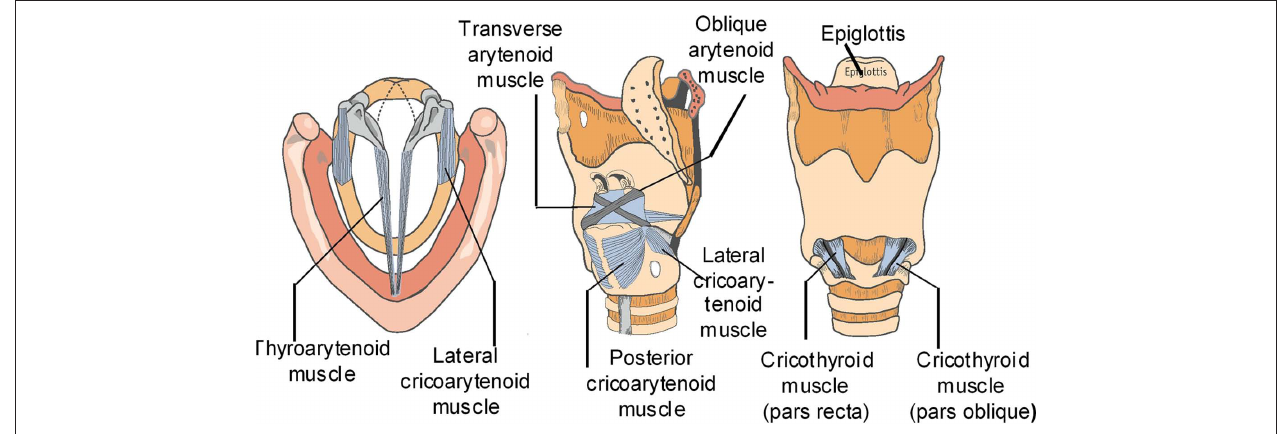
Figure 1 | From left to right, axial, oblique, and anterior views of the laryngeal cartilages and intrinsic laryngeal muscles.